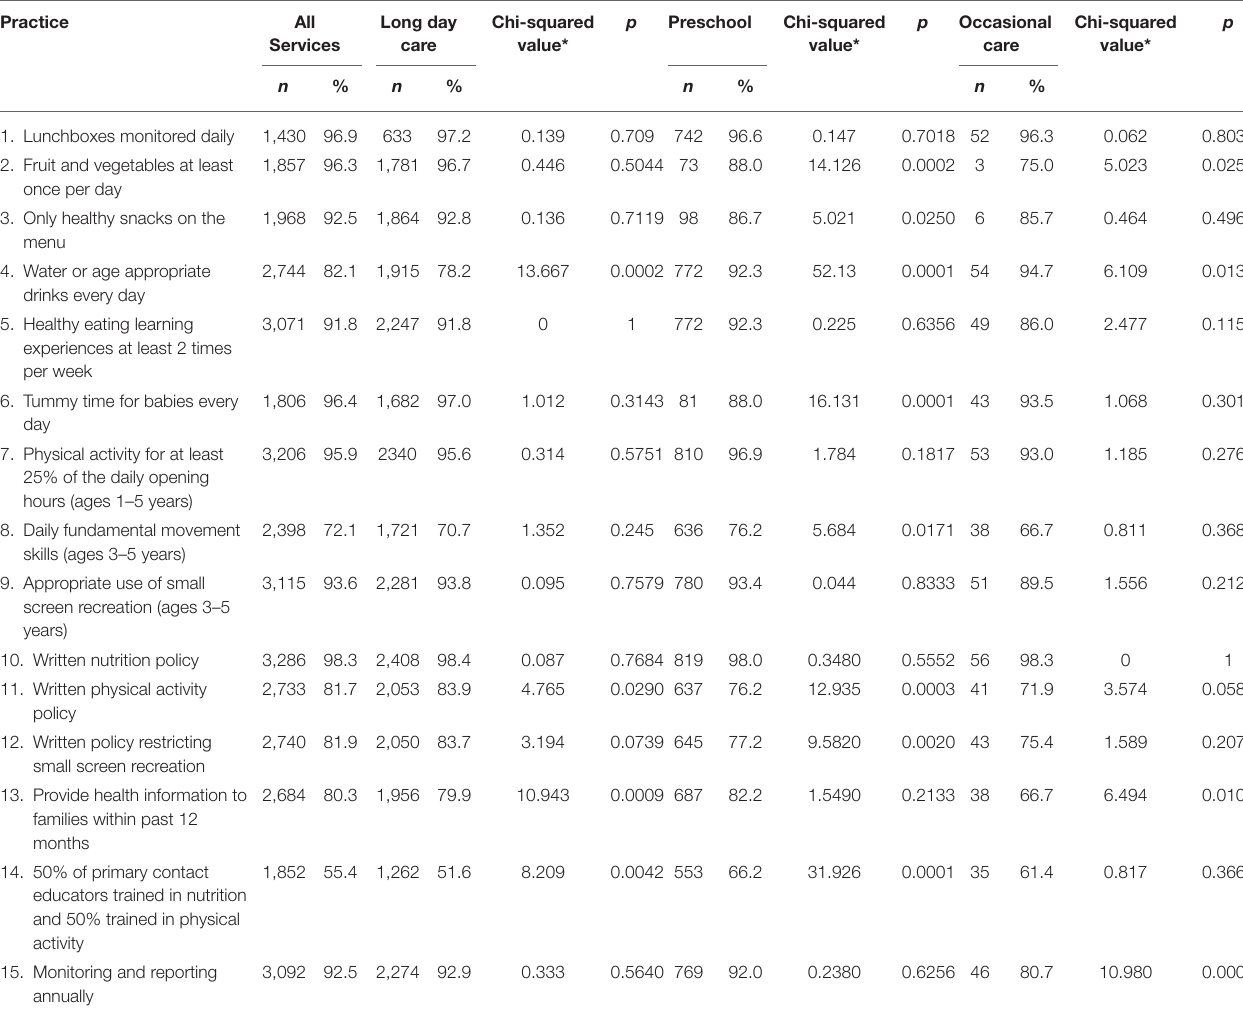
TABLE 3 | Practice achievement by service type (2017).